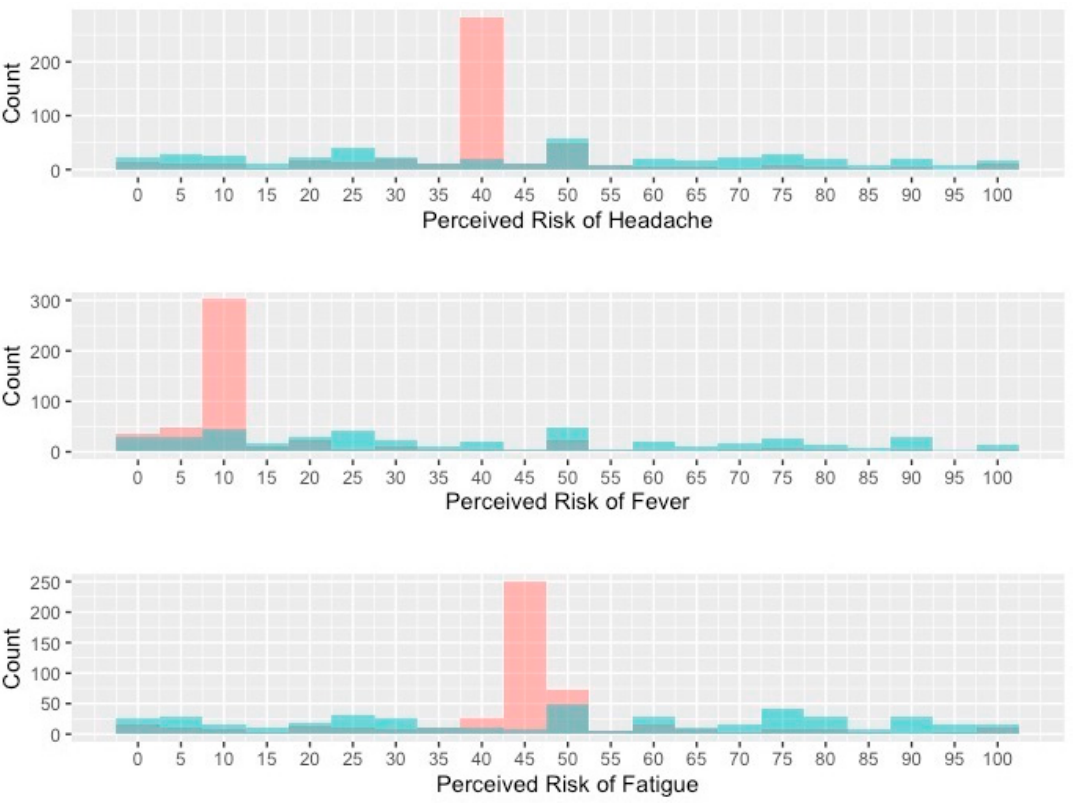
Figure 1. Mean relative perceived risk of side effects from COVID-19 vaccines when communicated using verbal or numerical probability descriptions. Bars show the mean perceived risk of participants—the stated numerical probability so larger bars represent larger deviations from the true risk of the side effect. Error bars represent standard deviations. In multivariable analysis, verbal descriptors were associated with higher perceived